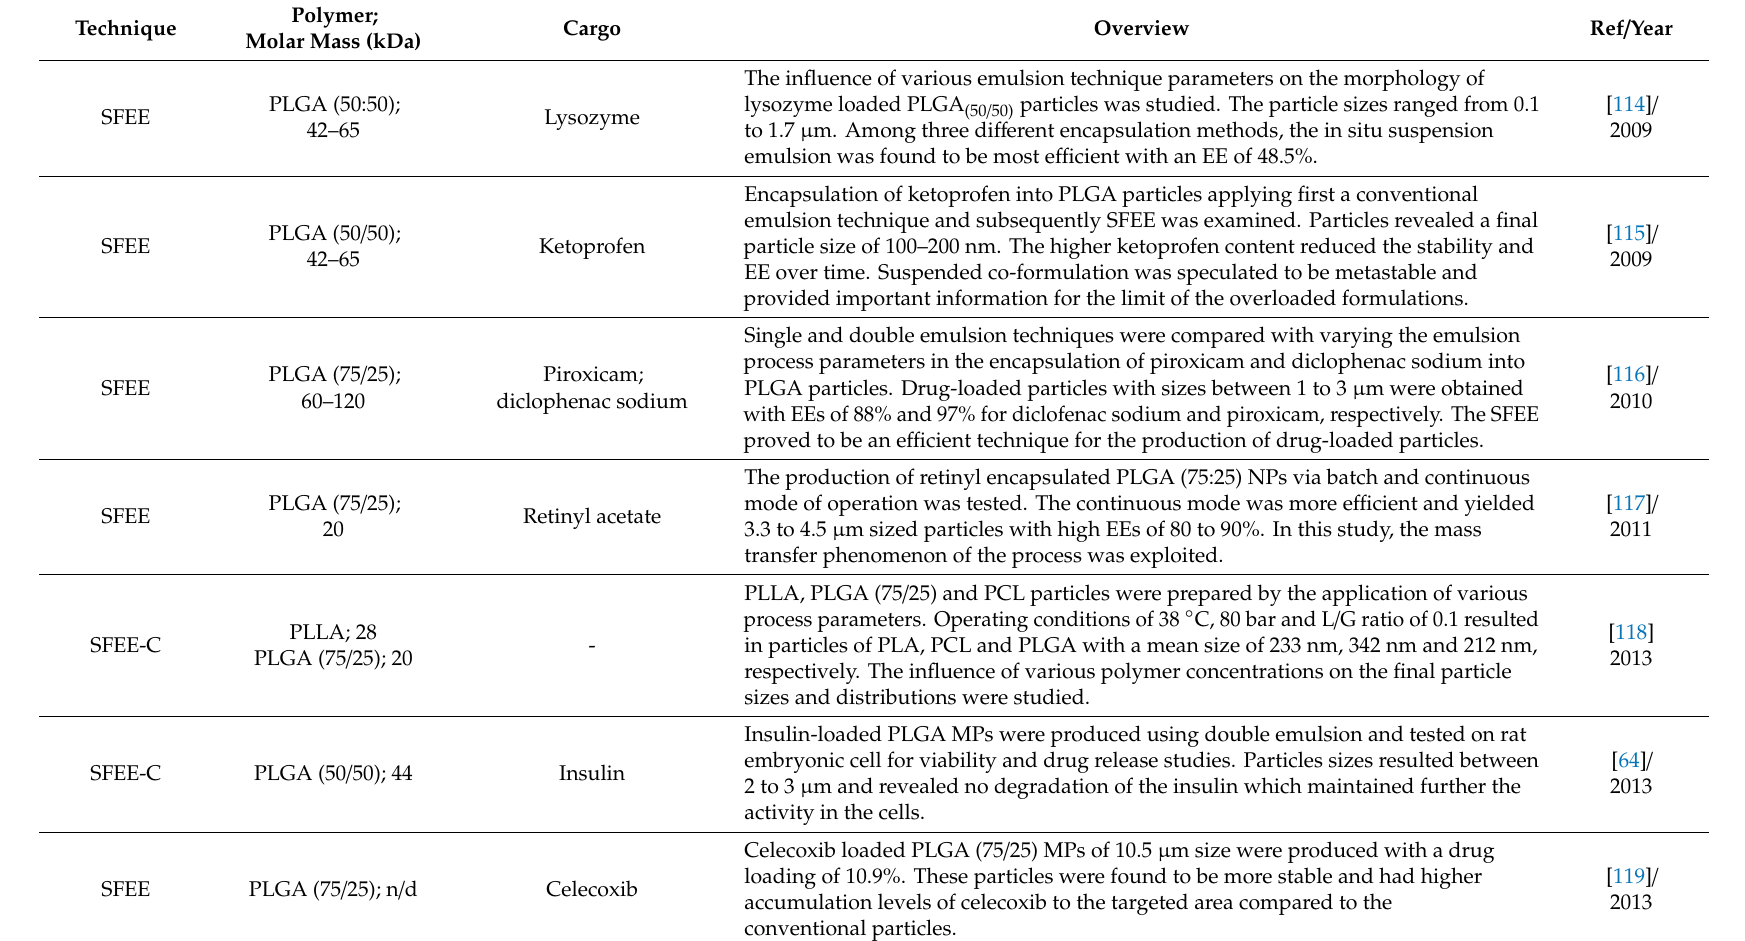
Table 3. Overview of loaded PLA / PLGA particles obtained using the supercritical fluid emulsion extraction (SFEE) method during the purification